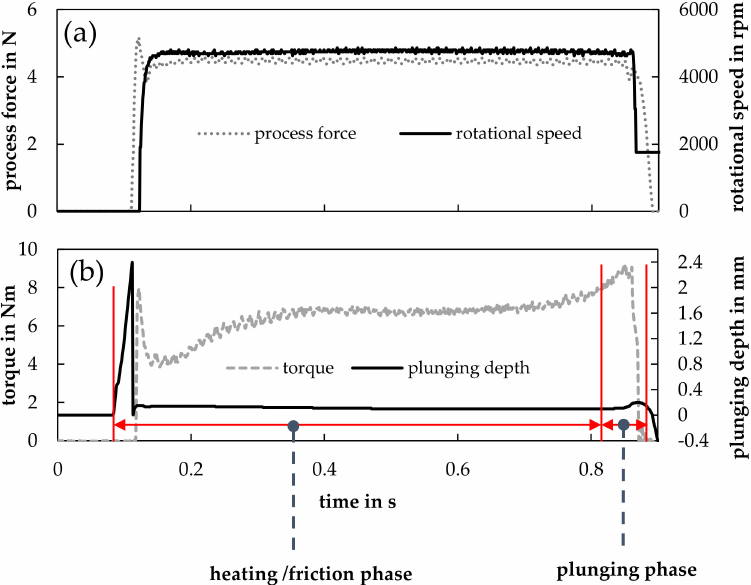
Figure 1. Process diagrams—process force and speed over time ( a ) as well as process torque and plunging depth over the time ( b